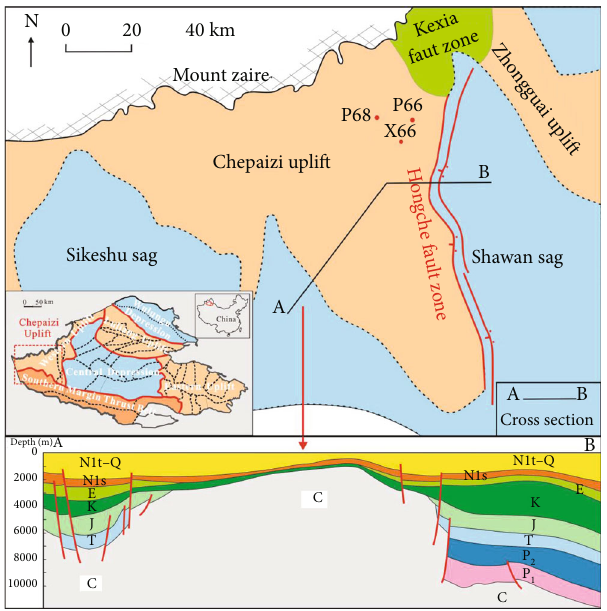
Figure 1: Regional geological map and structural framework of the Chepaizi